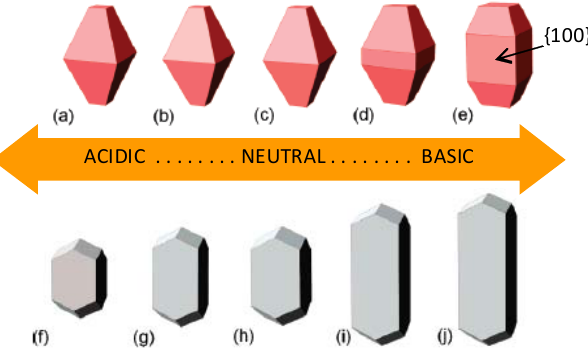
Figure 2. Morphology predicted for anatase ( top ) with ( a ) hydrogenated surfaces; ( b ) hydrogen-rich surface adsorbates; ( c ) hydrated surfaces; ( d ) hydrogen-poor adsorbates and ( e ) oxygenated surfaces, and rutile ( bottom ) with ( f ) hydrogenated surfaces; ( g ) hydrogen-rich surface adsorbates; ( h ) hydrated surfaces; ( i ) hydrogen-poor adsorbates and ( j ) oxygenated surfaces. Adapted with permission from ref. [22]. Copyright 2005 American Chemical Society.